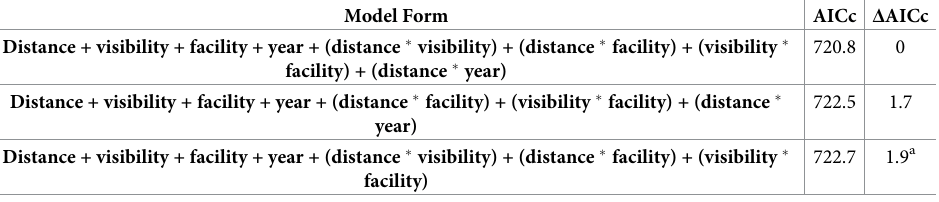
Table 4. Searcher efficiency models with delta ( Δ ) sample-size Akaike’s information criterion (AICc) � 2. Top models for decoy detection all included the main effects of distance, visibility, facility, and year. We selected the